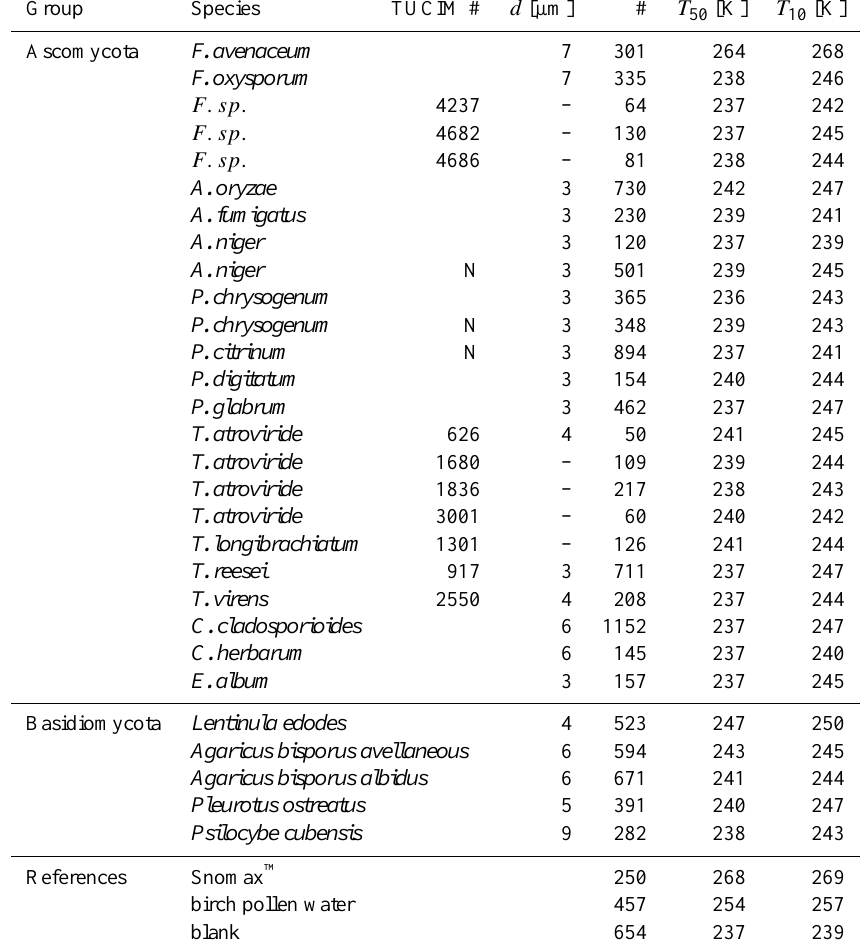
Table 2. A list of T 50 values for different ice nuclei in the oil immersion mode. Values of references are taken from Pummer et al. (2012). Species labeled with “N” in the TUCIM column are the food mold samples. d is the longitudinal diameter of a single spore, # the total number of counted